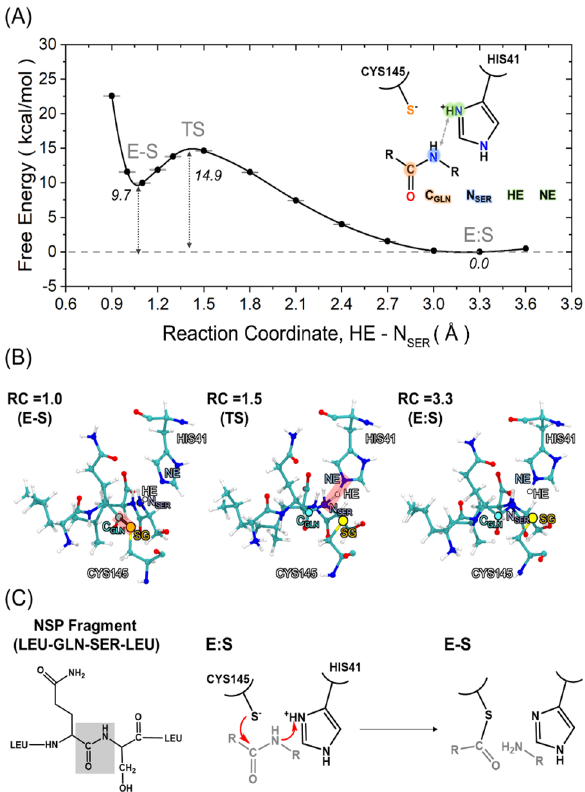
Figure 5. ( A ) Free energy profile for the formation of E-S complex with the NSP fragment as a function of the HE − N SER distance. ( B ) Representative snapshots taken at three different points along the reaction: the E:S Michaelis complex (left), transition state (middle), and E-S intermediate (right). ( C ) A proposed concerted reaction mechanism from the E:S state to E-S complex of the NSP